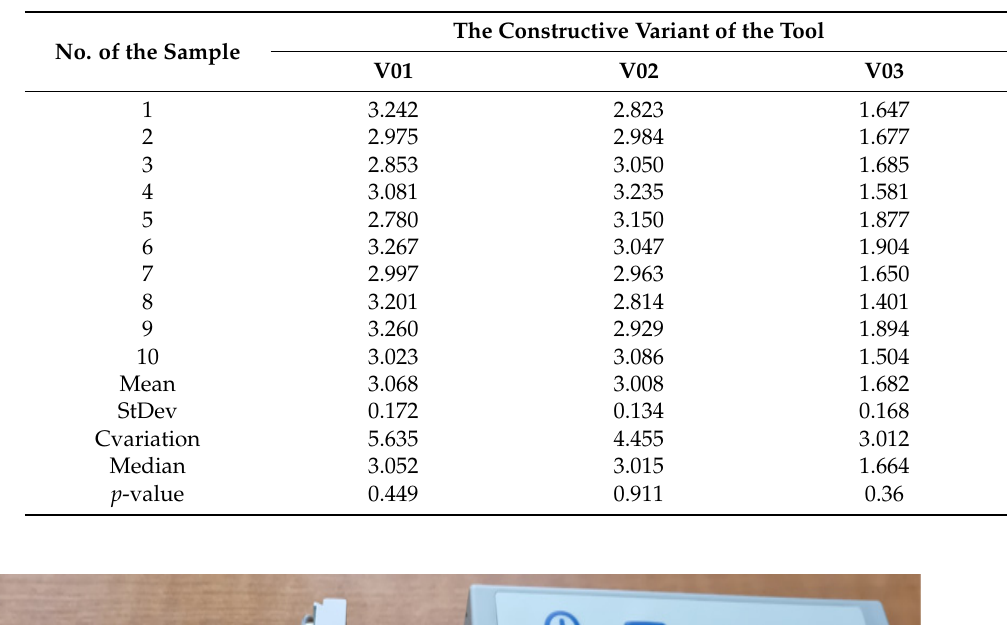
Table 9. The measured roughness values for the S5 sample, Ra ( µ m).